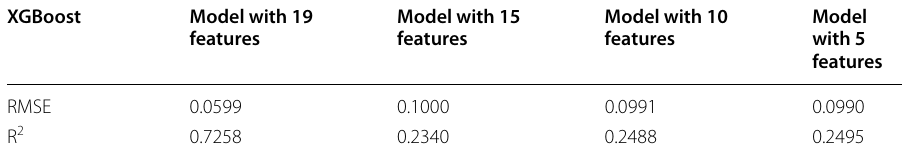
Table 11 Performance metrics with